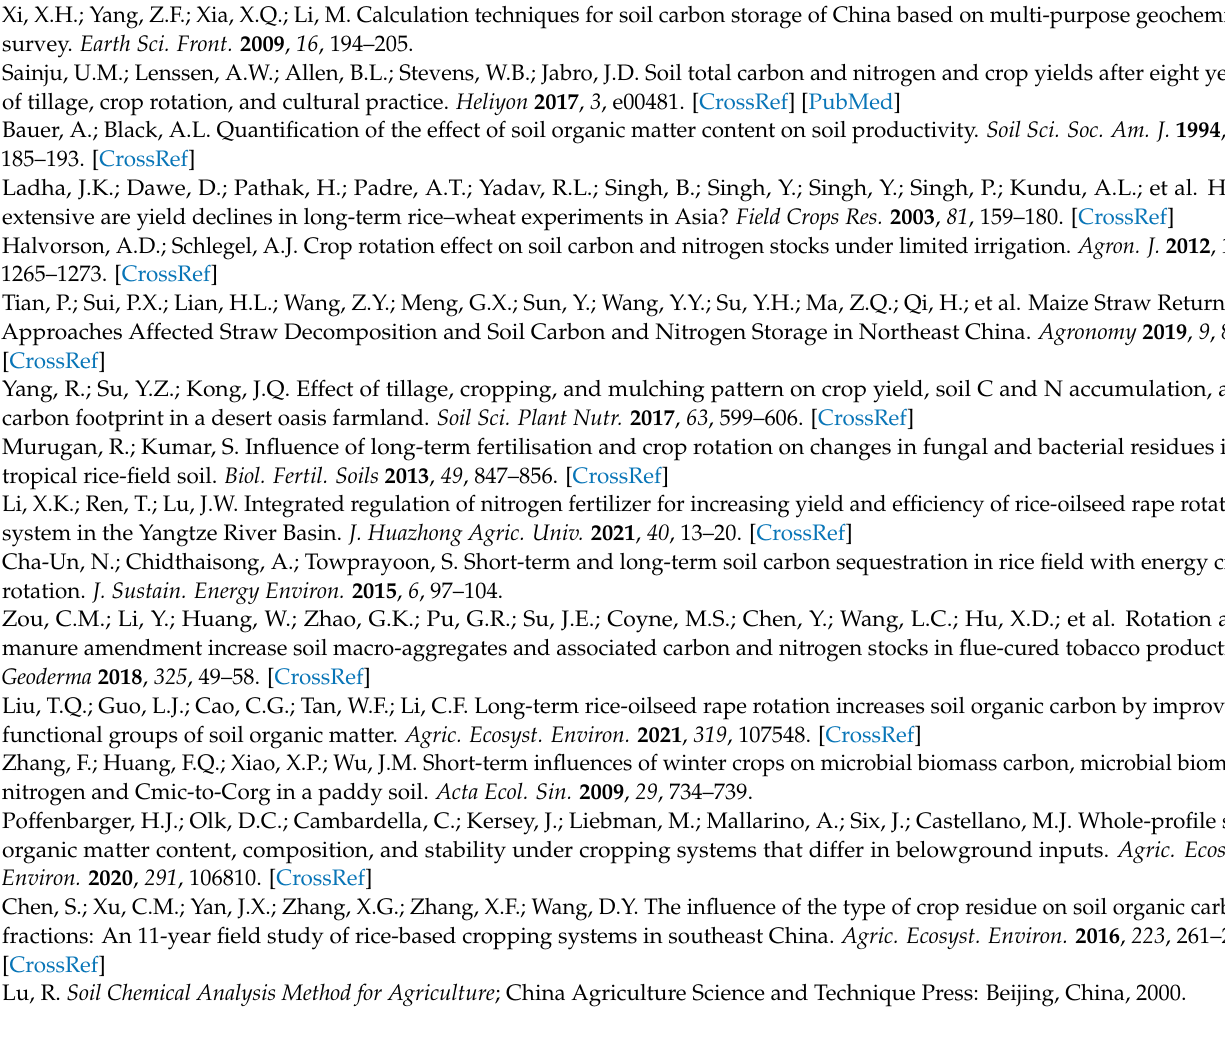
Table S3: Percentage share of total soil C and N content in investigated layers in ratio total stock in 0–50 cm (%); Table S4: The stratification ratios of SOC, TN, and AN